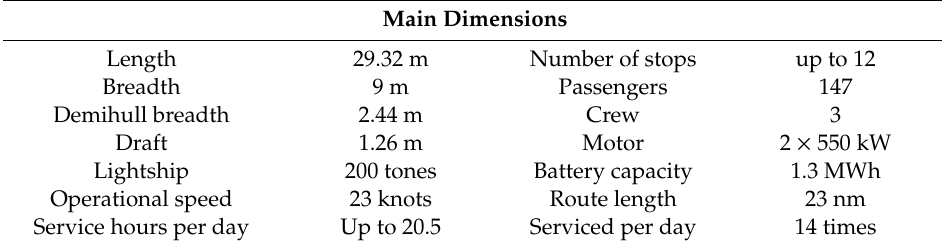
Table 4. Case ship specifications and general arrangement.